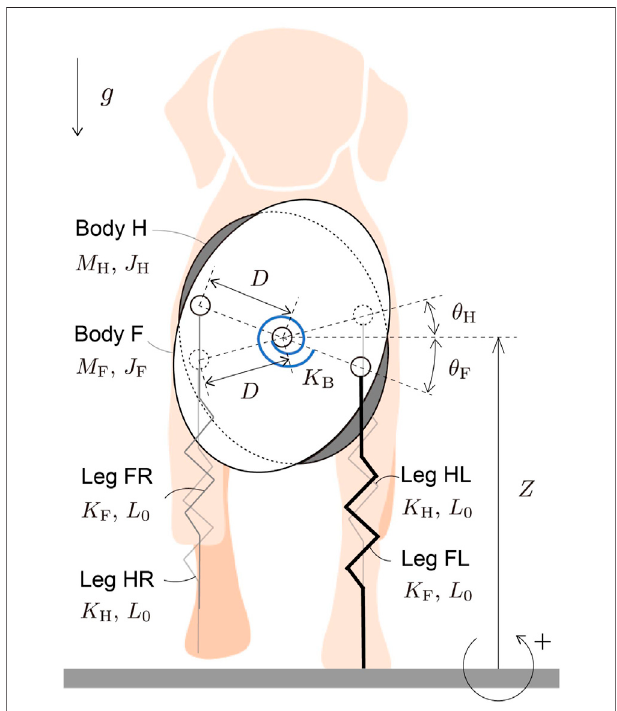
FIGURE1| Ourmodel composed oftworigid bodiesand four massless springs. The bodies are connected at their COM by a joint with a torsional